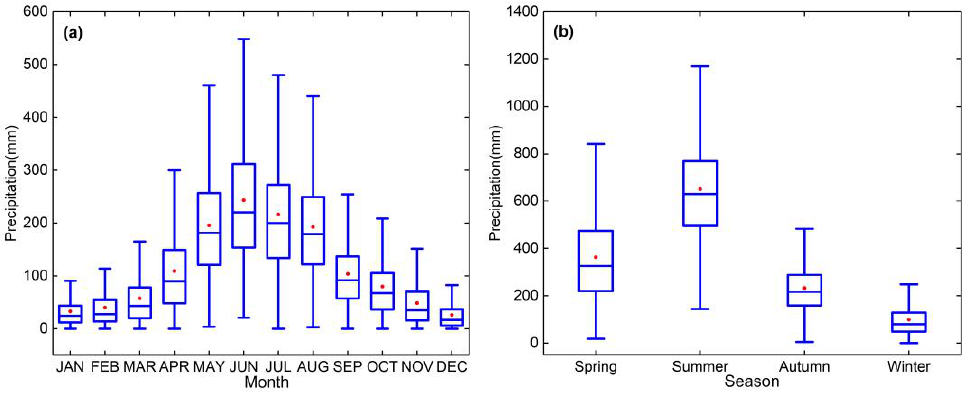
Figure 4. Boxplots of the precipitation for 36 meteorological stations in 1960 – 2008. ( a ) Monthly precipitation distribution; ( b ) seasonal precipitation distribution. Red dots represent the mean of precipitation.